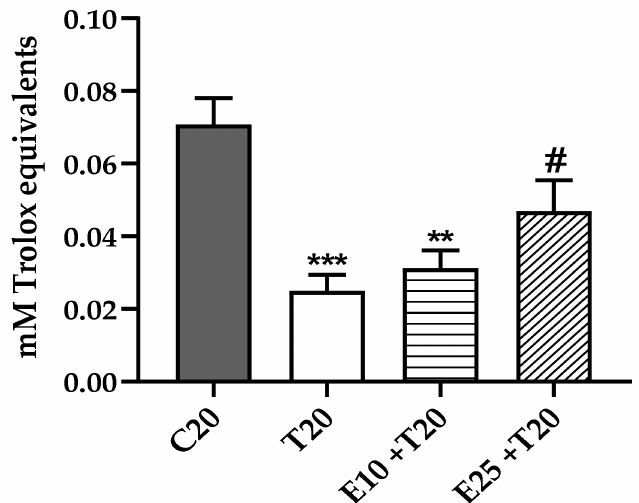
Figure 2. E ff ect of Rhus coriaria L. extract and UV-A rays on total cellular antioxidant activity, measured as mM Trolox equivalents after normalization on cell’s viability. HMEC-1 were treated for 1 h with 10 or 25 µ g / mL of mERC (E10, E25) and exposed to 20 J / cm 2 UV-A (T20). Results are expressed as mean ± SEM, n = 5. Statistical analysis: One-Way ANOVA with Bonferroni’s post hoc analysis. ** p < 0.05, *** p < 0.001 vs. C20, # p < 0.01 vs.